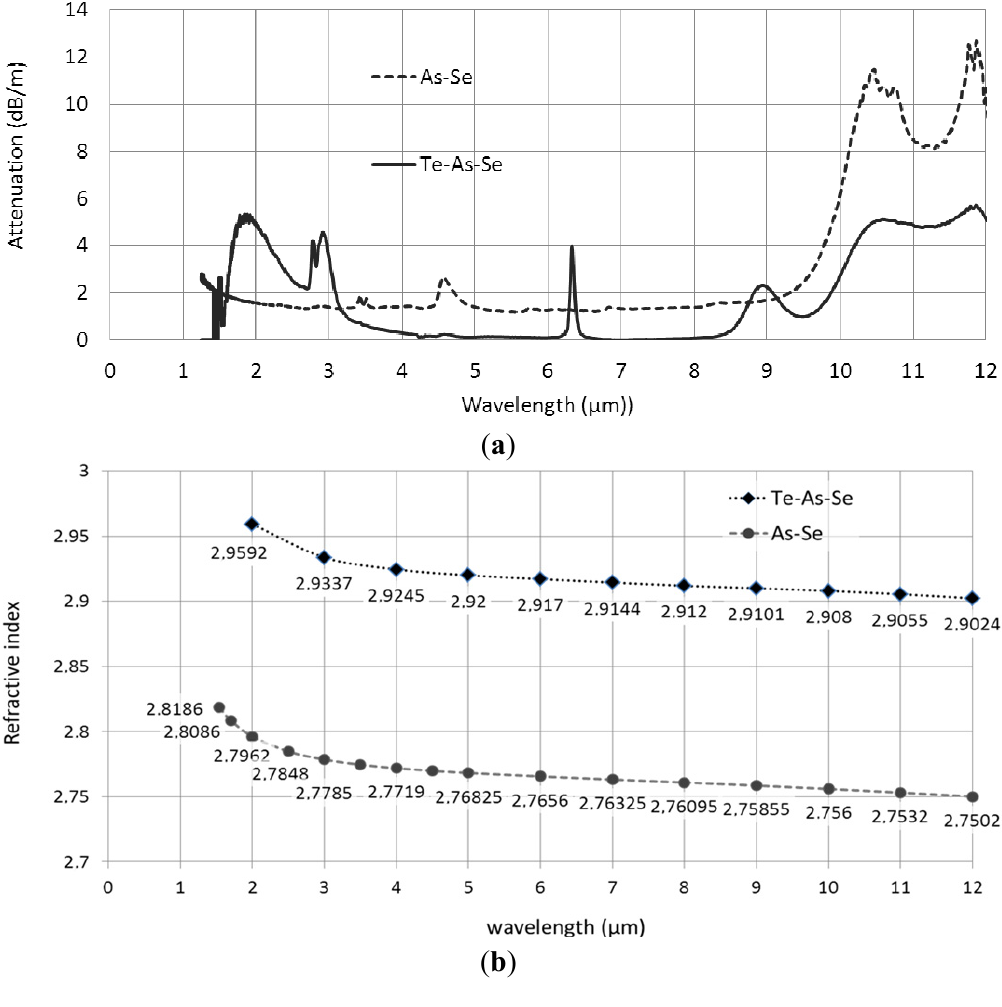
Figure 1. ( a ) As Se and Te As Se glasses attenuation curves; and ( b ) refractive indices 38 62 20 30 50 of As Se and Te As Se 38 62 20 30 50